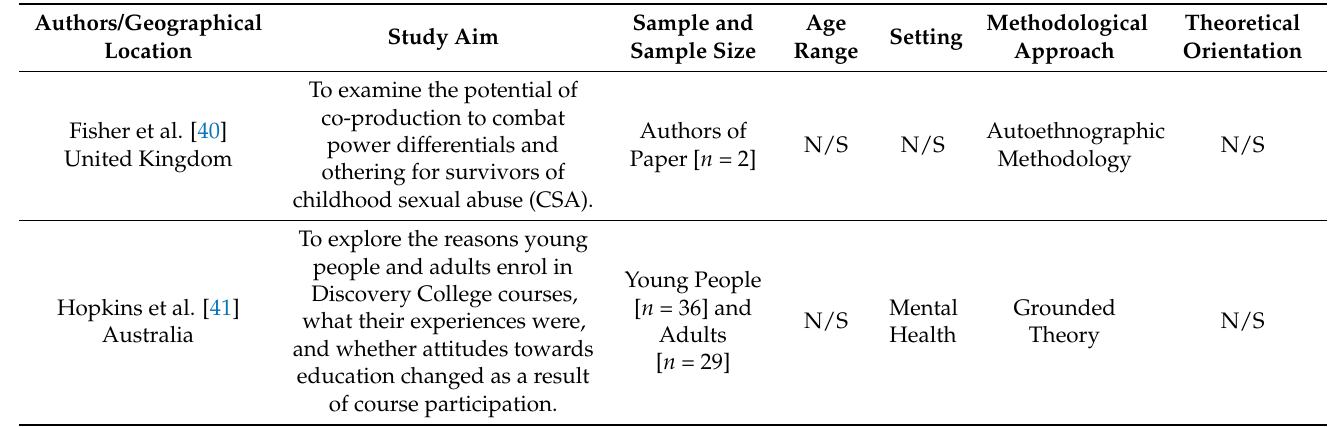
Table 2. Comparative table of included studies.